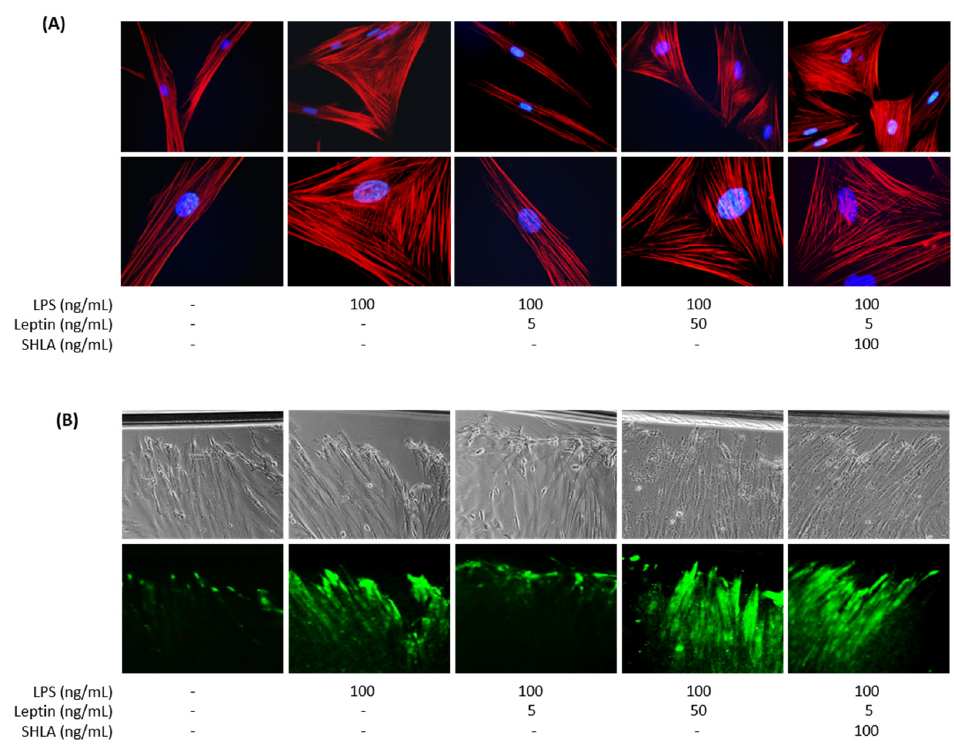
Figure 2. Effect of leptin on LPS-induced myometrial differentiation on myocytes/macrophages co-culture. Myocytes and macrophages were co-cultured and treated with LPS, leptin, and/or SHLA. ( A ) Merged fluorescence images of phalloidin (red) for actin cytoskeleton and DAPI (blue) for nucleus. Pictures were taken with an epifluorescence microscope at ×400 (upper row) and ×1000 magnification (lower row) in randomly selected fields and are representative of five pictures for each condition from six independent experiments. ( B ) Phase-contrast images (upper row) and fluorescence images of LY (lower row) transfer to adjacent cells after scrape loading. Pictures are representative of three independent experiments and were taken with an inverted microscope at ×200 magnification in randomly selected fields.